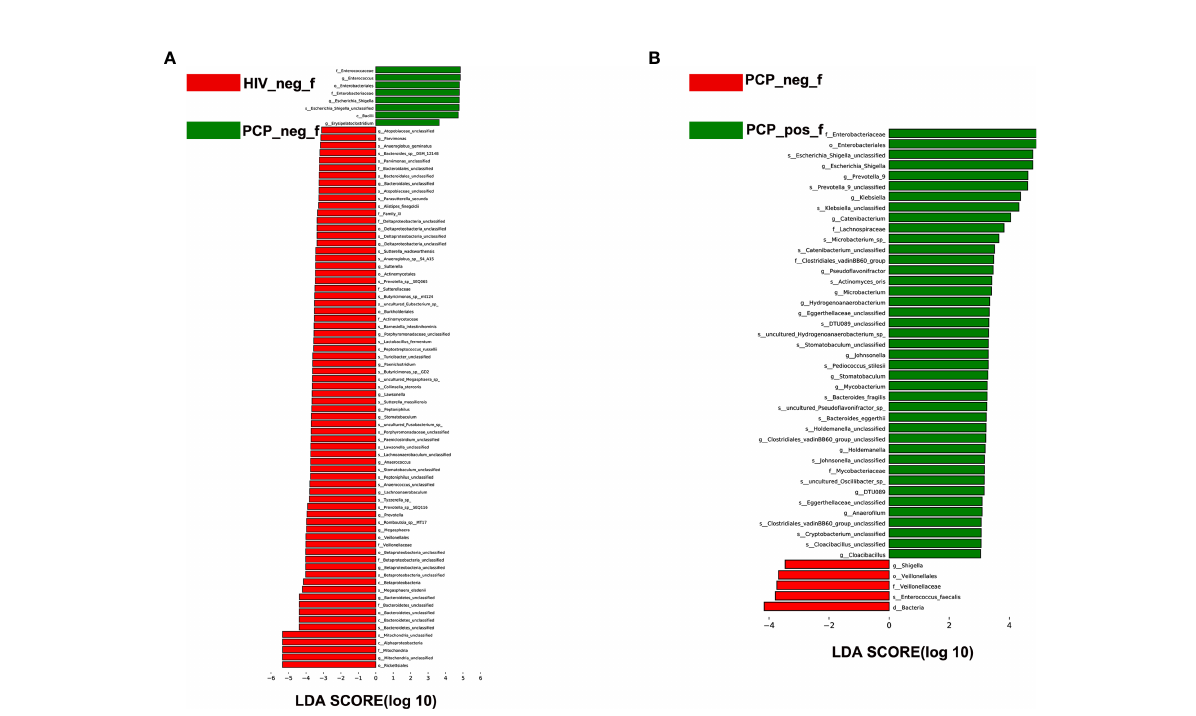
FIGURE 5 LEfSe analysis of intestinal fl ora. LEfSe identi fi ed the taxa with the greatest differences in abundance between groups. (A) LEfSe analysis of the intestinal microbiota in HIV+ and HIV- groups. (B) LEfSe analysis of the intestinal microbiota in PCP+ and PCP- groups. HIV_neg_f: HIV-